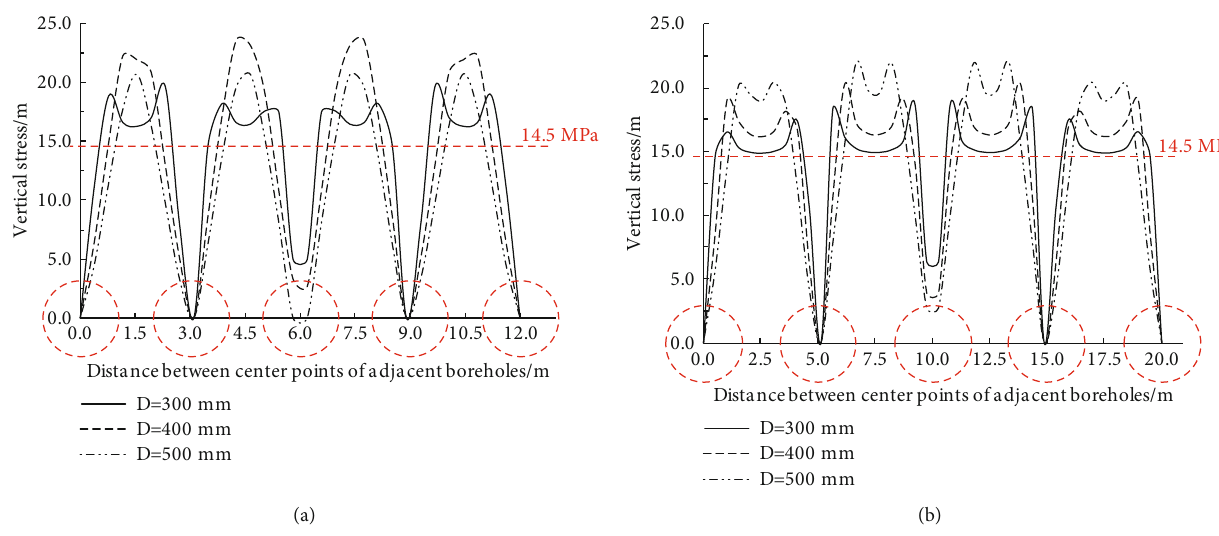
Figure 14: The numerical simulation results of di ff erent spacing between adjacent water jet boreholes. (a) When L is 3.0m. (b) When L is